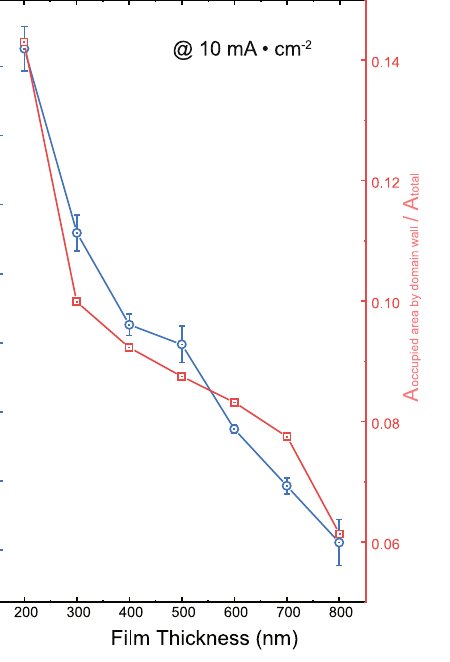
Fig. 4 | The origin of magnetization-caused increment in OER. a The OER overpotentialdropofNiFe fi lmsaftermagnetization(leftaxis,blue)andtheratioof the surface area occupied by domain walls to the total surface area of NiFe fi lms (right axis, red), as a function of fi lm thickness. Error bars represent the standard deviation obtained from three independent measurements. b The pro fi le of a domain wall in the NiFe fi lm with arrows denoting the magnetization